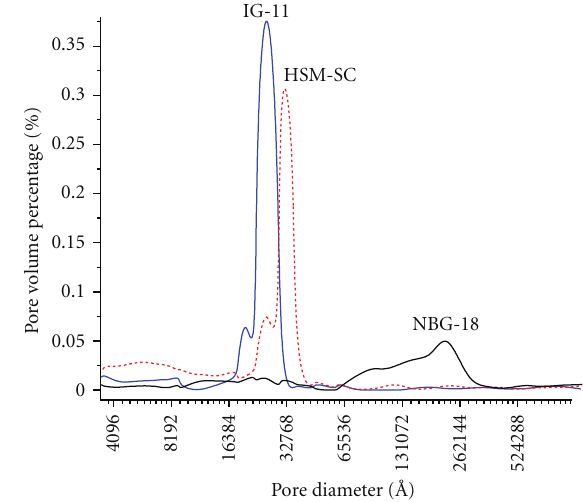
Figure 1: Pore diameter distribution of the graphite samples.